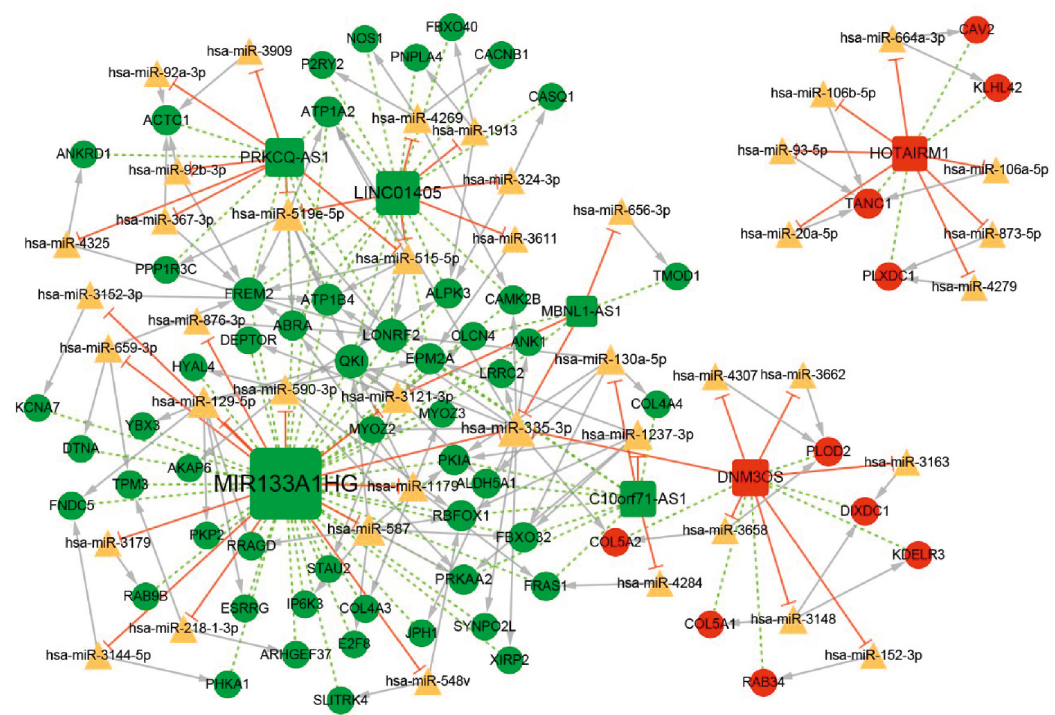
Figure 6: The differentially expressed subnetwork of the ceRNA network in tendinopathy. The red and green circles represent upregulated and downregulated mRNAs,